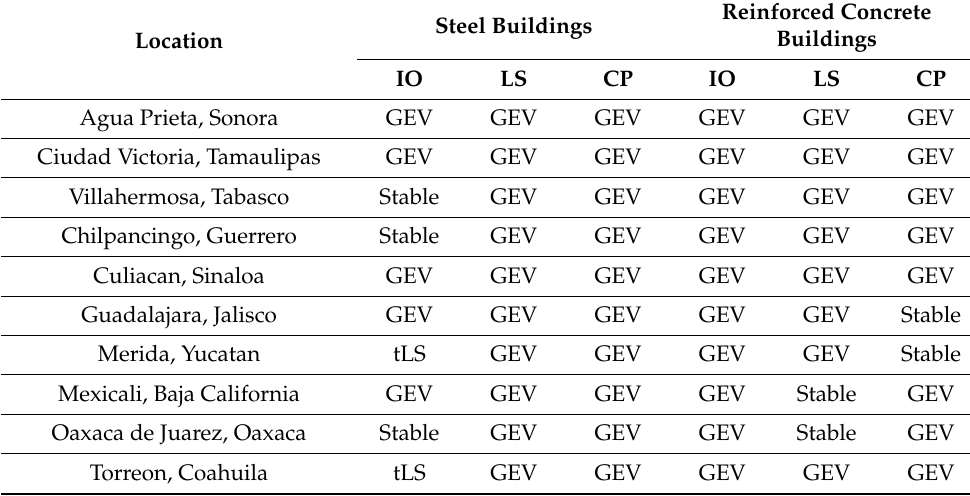
Table 6. Probability distribution functions for every building and location.